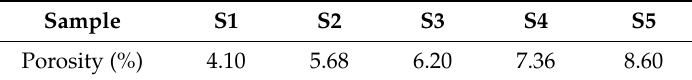
Table 2. Porosity estimation of sintered samples.